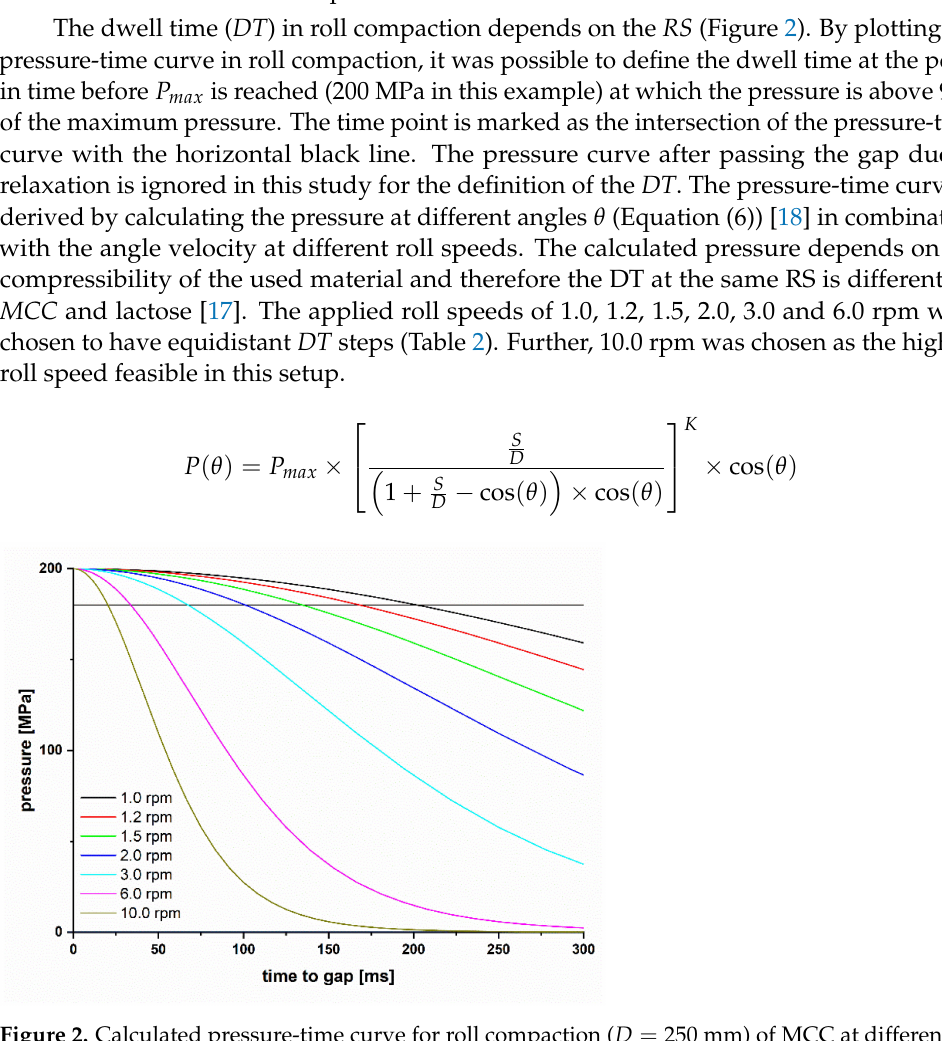
Figure 2. Calculated pressure-time curve for roll compaction ( D = 250 mm) of MCC at different RS from 1.0 to 10.0 rpm and a fixed P max of 200 MPa. The dwell time is marked as the intersection of the horizontal black line at 180 MPa (90% of P max ) and the pressure